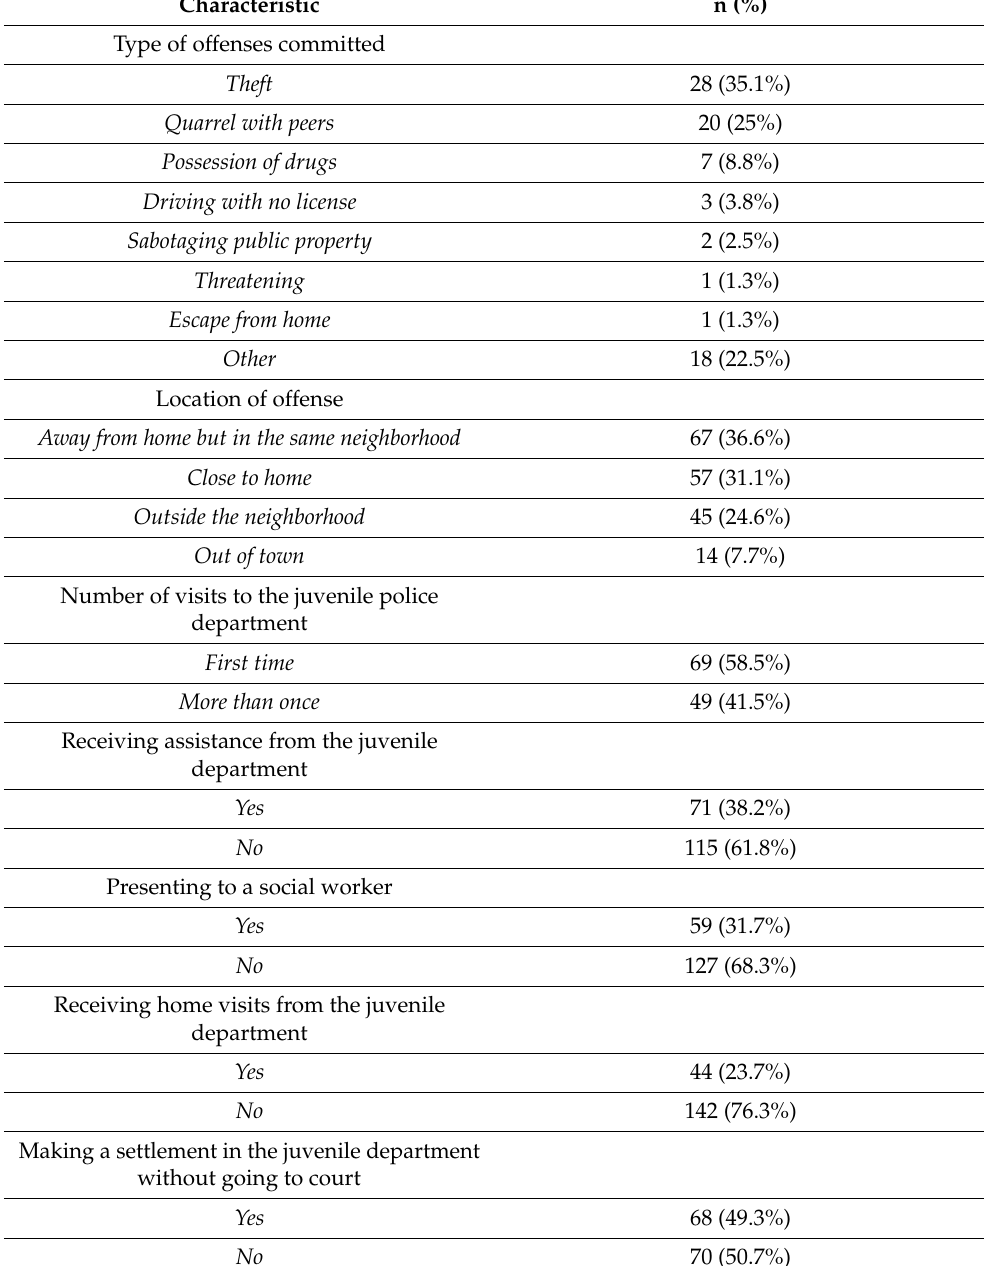
Table 4. Juvenile delinquents’ offenses commitment and handling approaches (N =